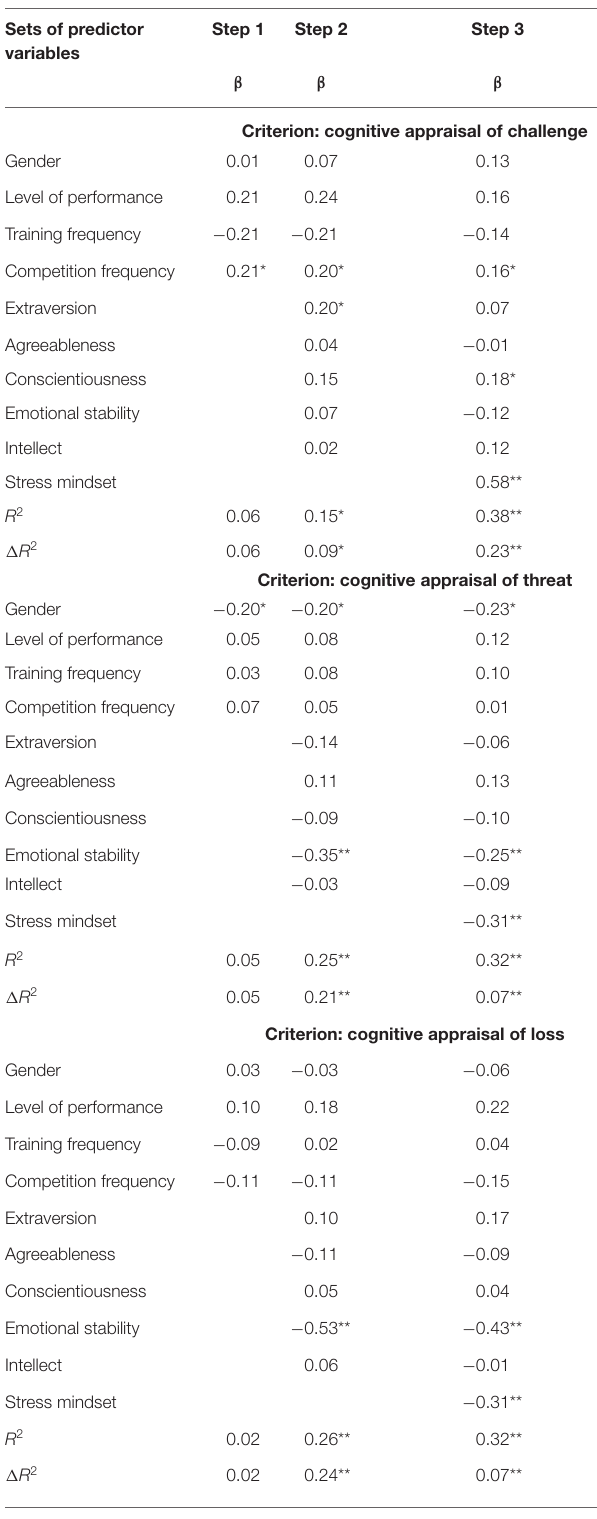
TABLE 3 | Hierarchical regression analyses: the additive role of personality dimensions and stress mindset in accounting for cognitive appraisals of stress. Sets of predictor